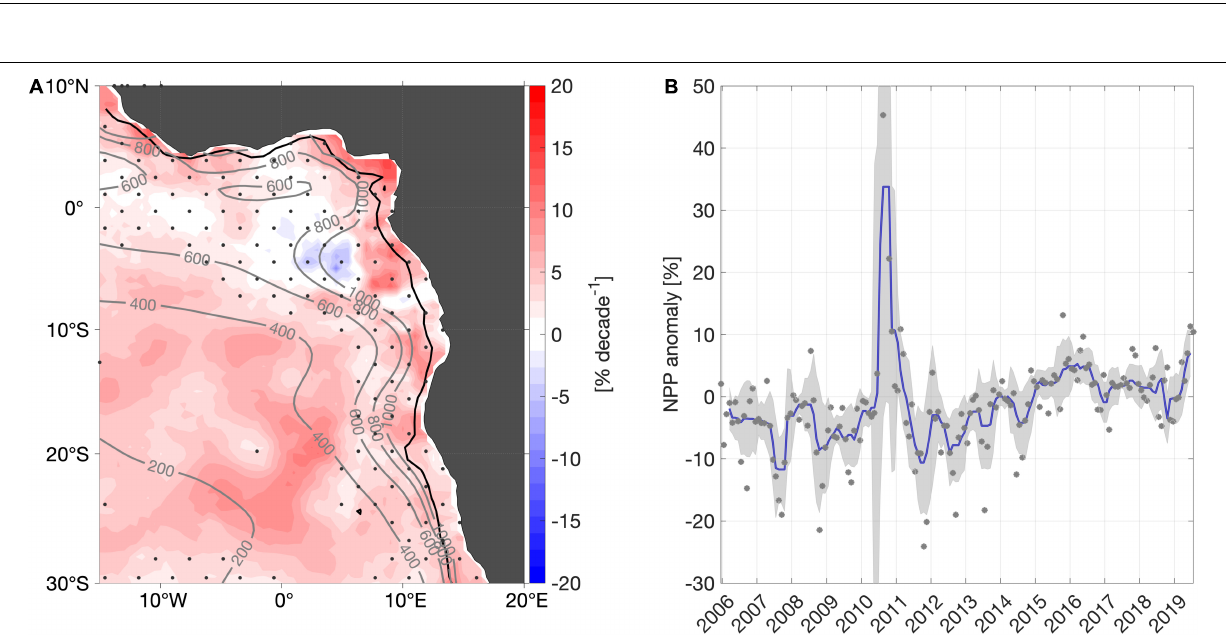
FIGURE 13 | (A) Decadal trend of net primary production (NPP) deduced from satellite observations from Ocean Productivity site for the time period of 2006–2019. The decadal trend has been evaluated from the anomalies relative to the corresponding monthly means. Areas where the trend is not of 95% significance are stippled. The gray contour lines in (A) show the mean NPP field. The black contour line indicates the 2,000 dbar isobath of the shelf region. (B) Six months running median NPP anomaly in SETA region (10–20 ◦ S, 5 ◦ W–15 ◦ E) in percent (blue line). Anomalies are computed to the monthly mean. Shading denotes the standard deviation and dots refer to the given monthly values from the